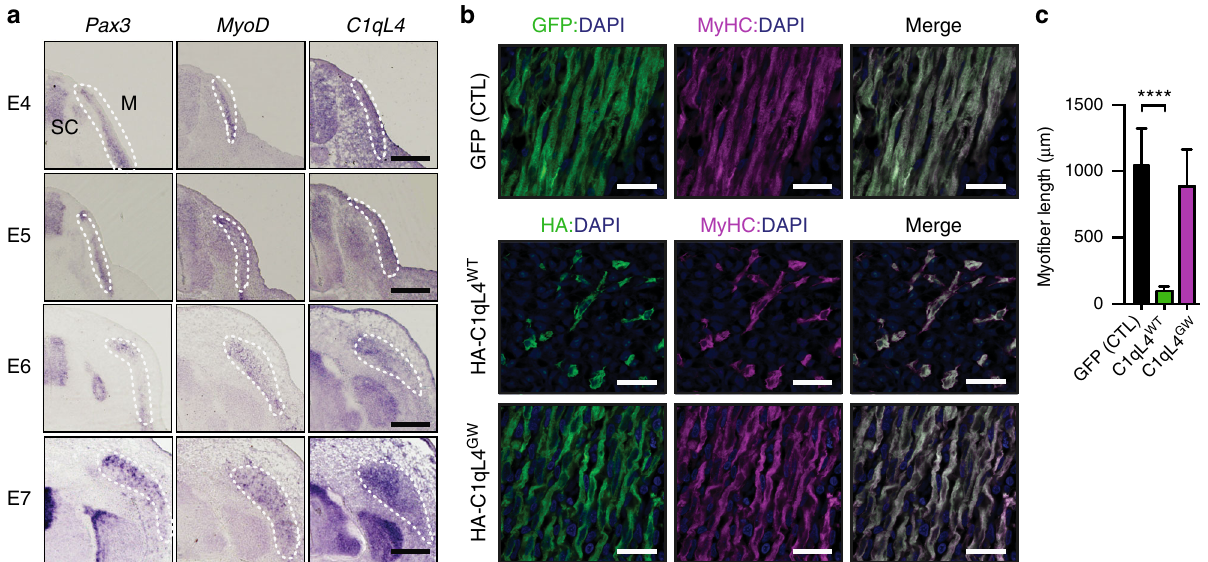
Fig. 4 Overexpression of C1qL4 blocks myoblast fusion in ovo. a In situ hybridizations of anti-sense DIG-labeled riboprobes demonstrate that endogenous C1qL4 (right) is expressed in muscle cells that also express the myocyte differentiations Pax3 and MyoD (left and middle) at the indicated embryonic days of chicken embryo development. C1qL4 is also expressed in the spinal cord. SC, spinal cord; M, muscle. b Expression of HA-C1qL4 WT in muscle progenitors blocks myoblast fusion in ovo in chick embryos. In contrast, C1qL4 de fi cient in BAI3-binding (HA-C1ql4 GW ) has no effect on myoblast fusion. c Length of myo fi bers ( μ m) was quanti fi ed for each electroporation condition. Myo fi bers were stained for Myosin Heavy Chain (MyHC, MF20 antibody (purple)) and nuclei were revealed by DAPI (blue). Error bars indicate standard deviation. Scale bar = 100 μ m. One-way ANOVA followed by a Bonferroni test was used to calculate the P- values; **** P <